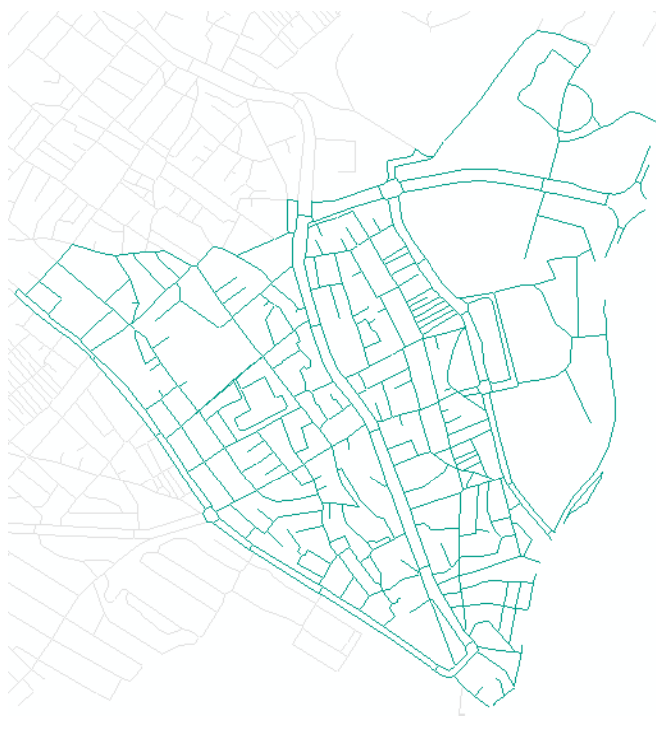
Figure 10. The existing PND set of the test site.